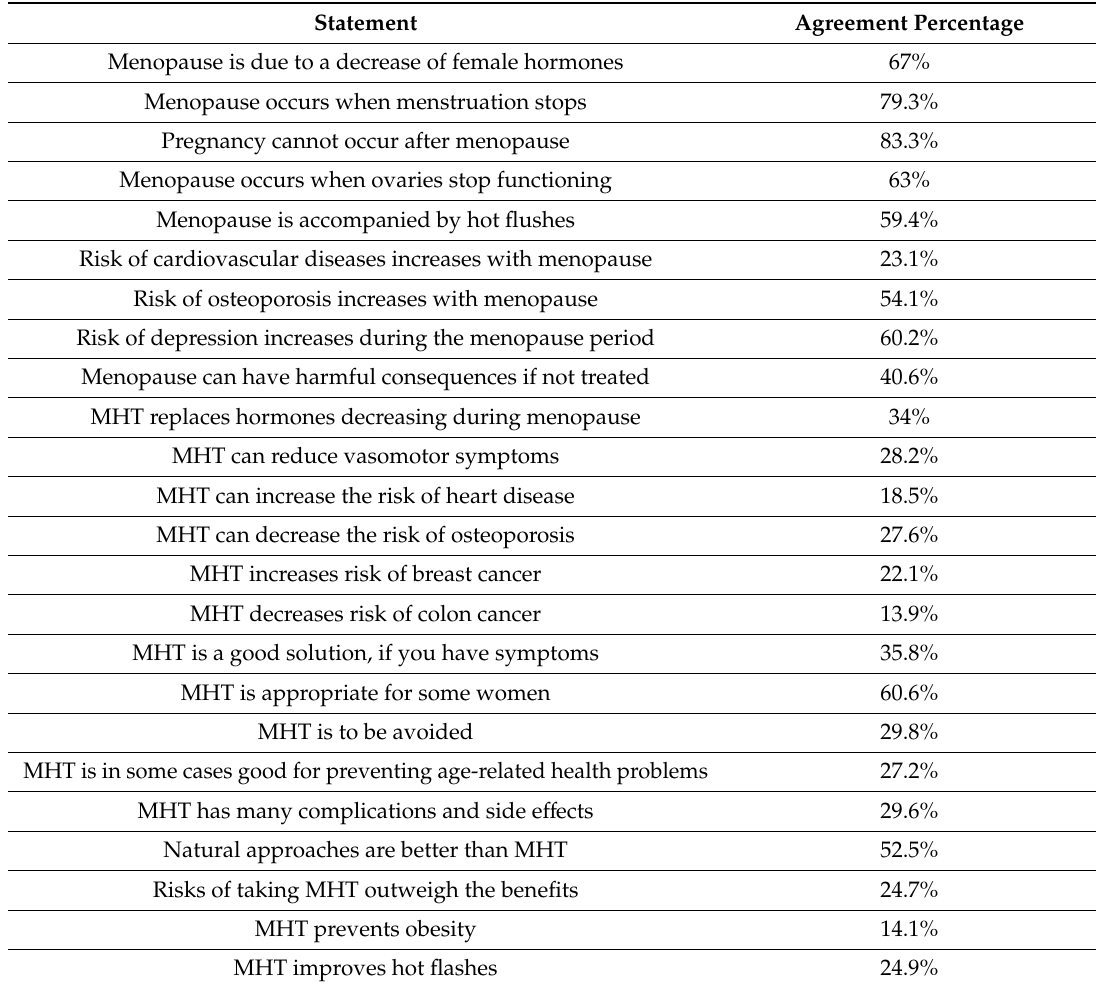
Table 3. Percentage of participants who agreed to individual items on the menopause and menopausal hormone therapy (MHT) knowledge scale (N =